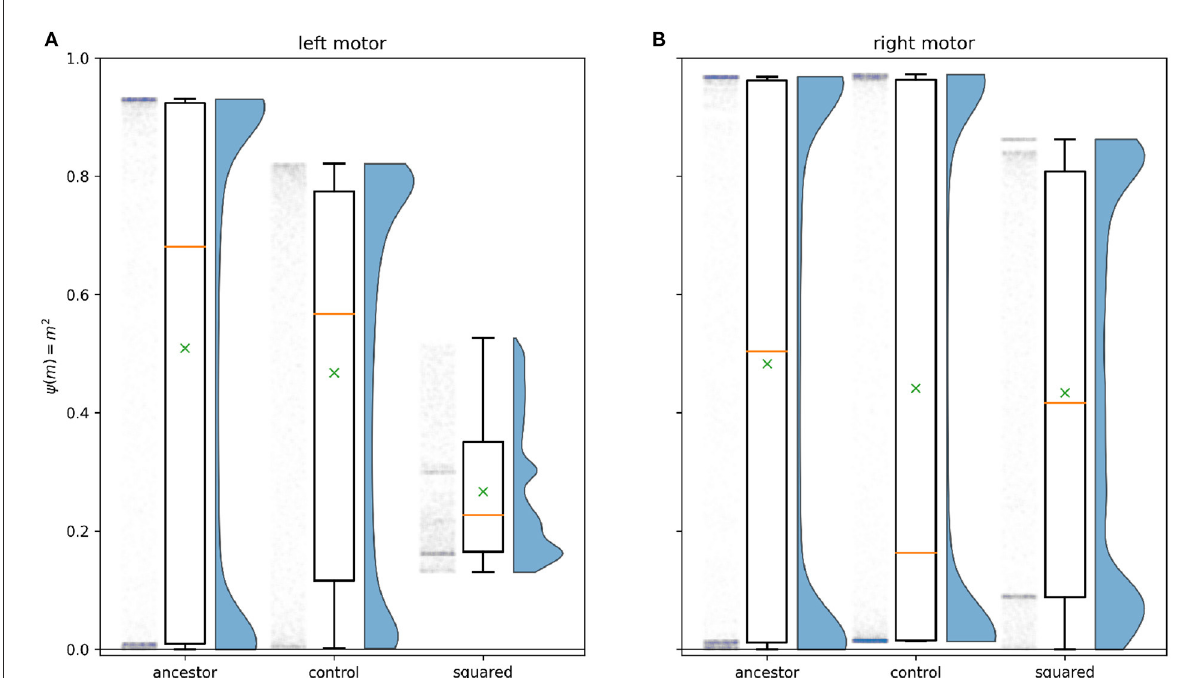
FIGURE9 Motor-driven interference is reduced in Experiment 2 relative to the ancestral population. The figure shows ψ ( m ) coordinates shown in Figure 3, for 20 < t < 50. (A) Note primarily the lowered mean, median and maximum interference with the left motor. Despite the right motor’s activity being spread across a wider range than either ancestor or control (see Figure 6), this spread is to low motor activity values, decreasing maximum right motor-sensor interference. (B) However, the right motor activity has definitely not been suppressed the way the left has, and the systems successful performance in the presence of this interference ultimately depends on the coordination of right motor-sensor interference with environmental stimulation of the right sensor (see main